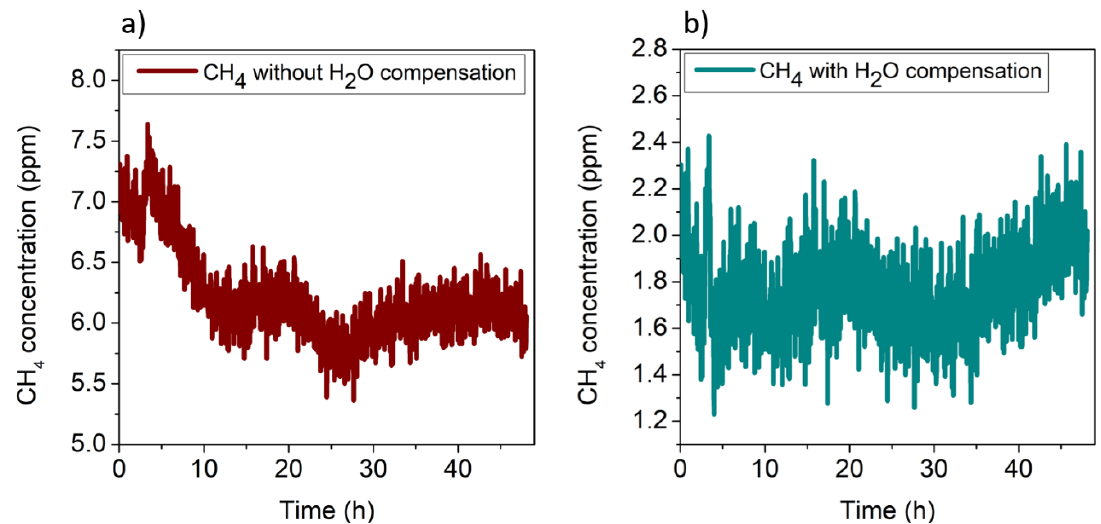
Figure 11. ( a ) QEPAS signal of the methane in laboratory air without water compensation; ( b ) methane QEPAS signal after the compensation with the absolute humidity recorded by the hygrometer.